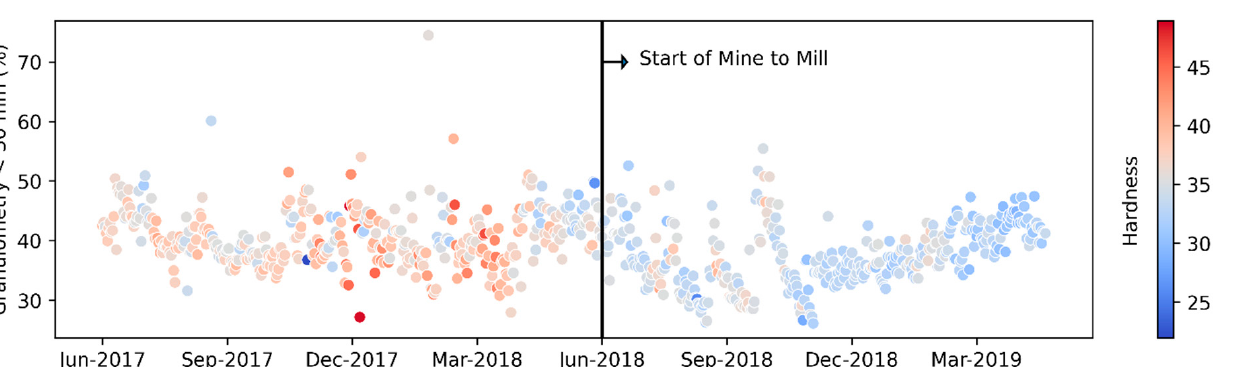
Figure 6. Average production of an SAG mill in tons per hour.